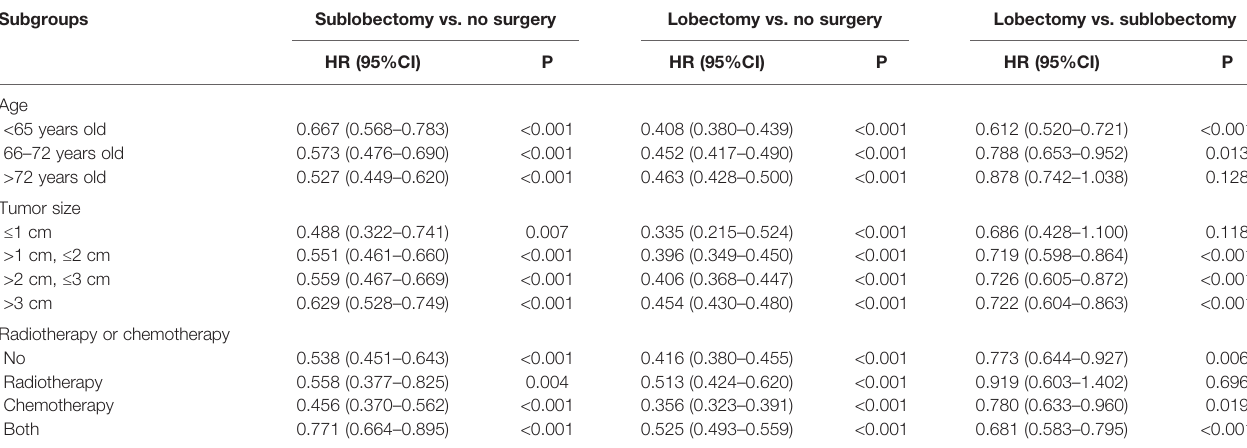
TABLE 4 | Multivariable Cox regression analysis of subgroups of all IIIAN2 stage NSCLC patients before IPTW. Subgroups